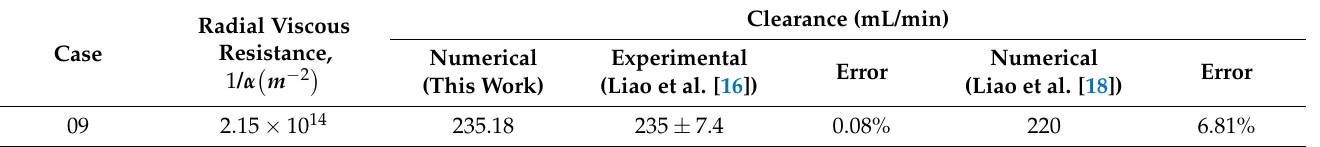
Table 10. Comparison between results obtained in this work and those available in the